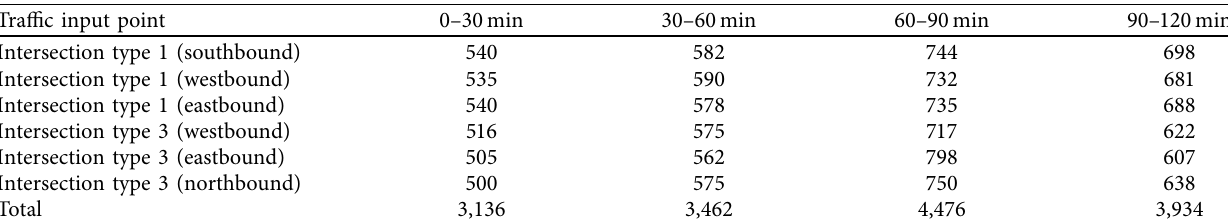
Figure 7: VISSIM road network of the central area of Sejong, Korea. Table 5: Trafc settings of the simulation